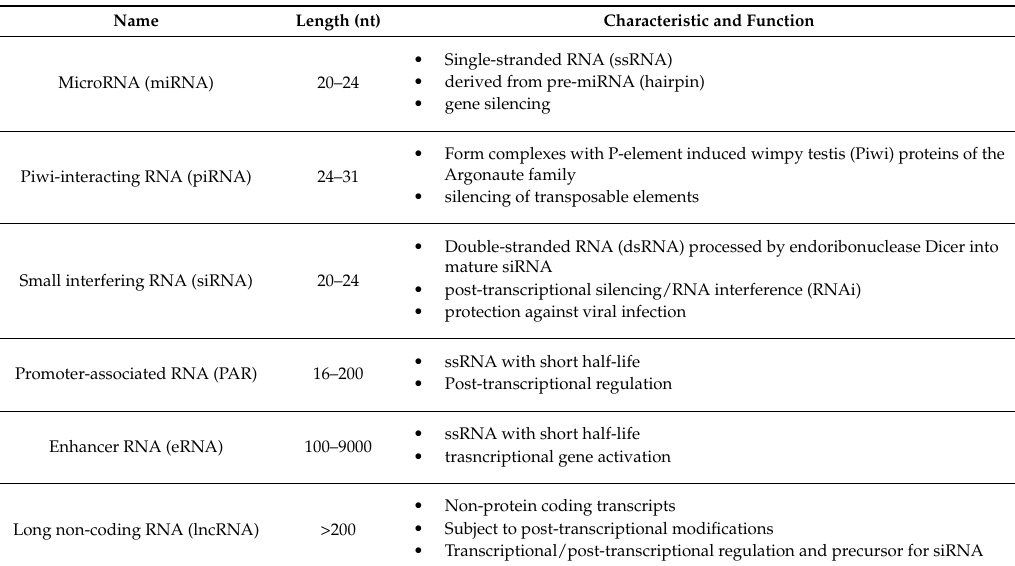
Table 2. Non-coding RNA (ncRNA) and their characteristics and